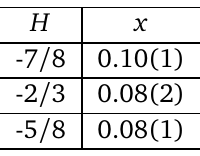
Table 3: Exponent x determining the behaviour of c ν ( q ) with q (34), obtained from fitting log c ν ( q ) . These values are to be compared to the value of the spin dimension, which remains equal to the pure percolation value 2 − D pure